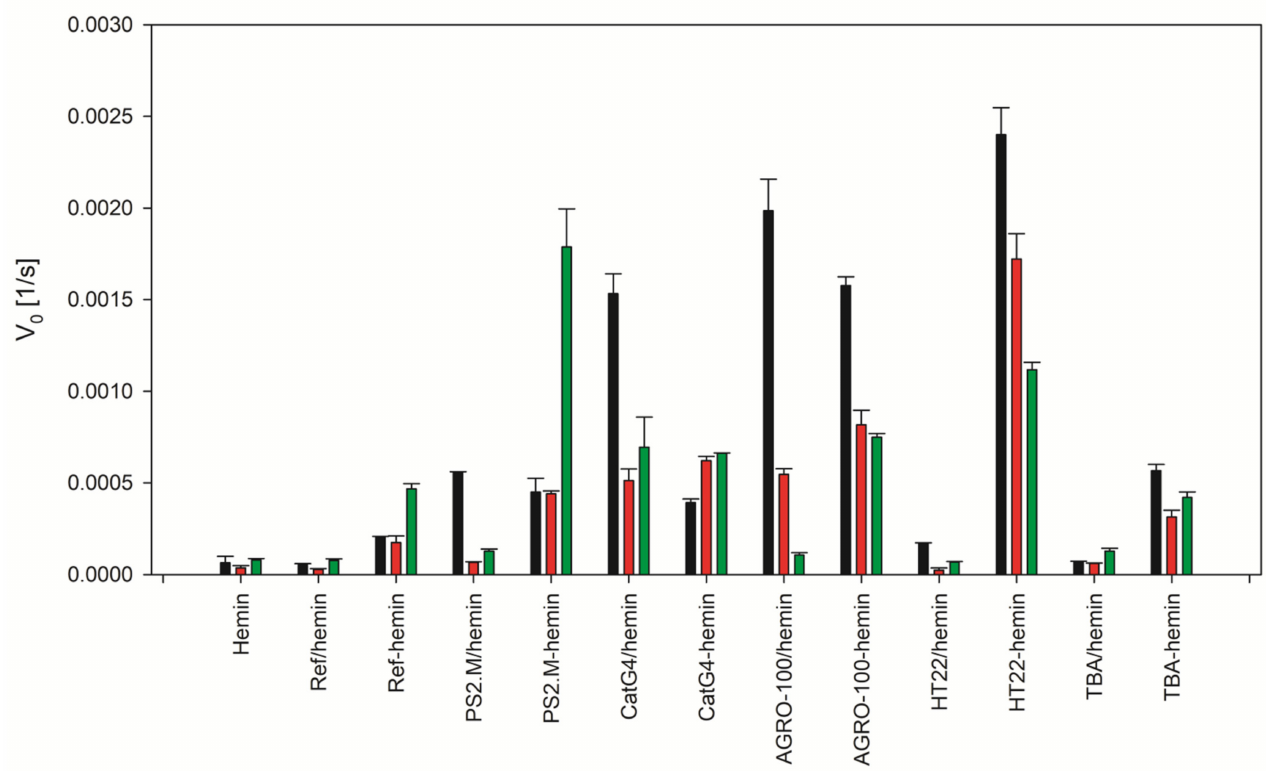
Figure 2. Initial velocity of ABTS per oxidation by hemin, DNA/hemin complexes and DNA-hemin conjugates in various cationic conditions: 100 mM KCl (black), 100 mM NaCl (red), without cations